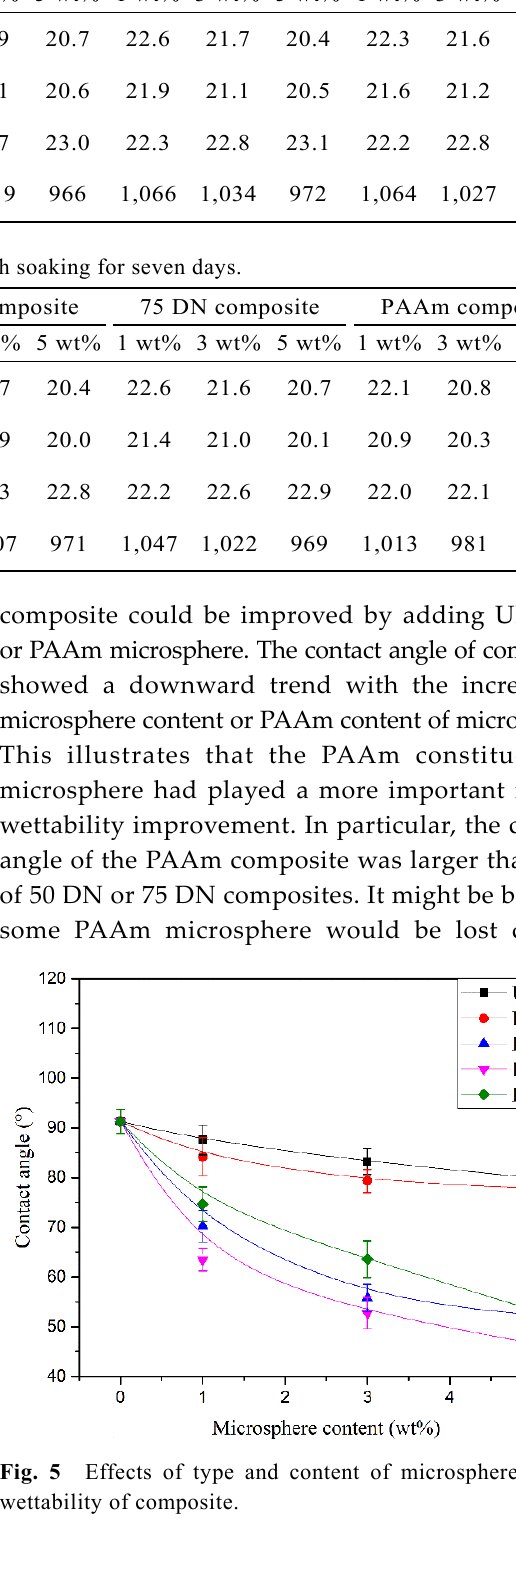
Table 1 Mechanical properties of UHMWPE and its composites without soaking. UF composite 50 DN composite 75 DN composite PAAm composite Material